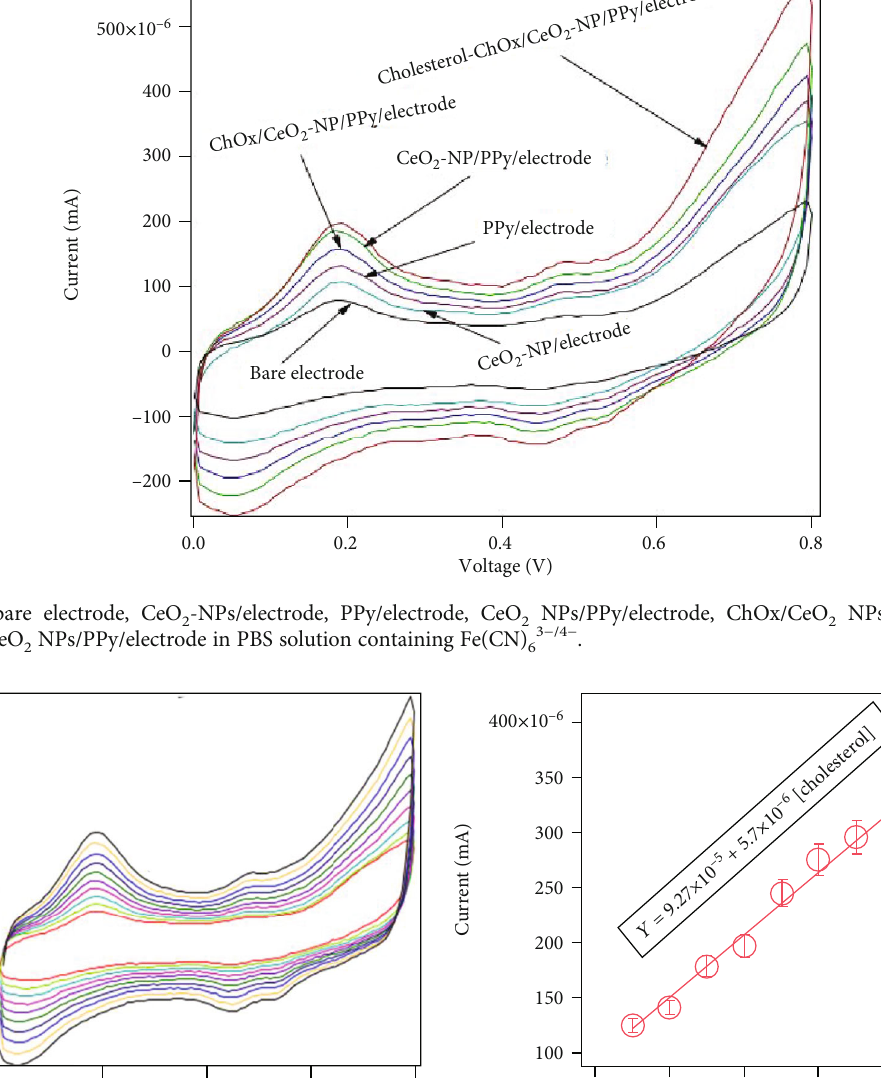
NPs/PPy/electrode in PBS solution 2